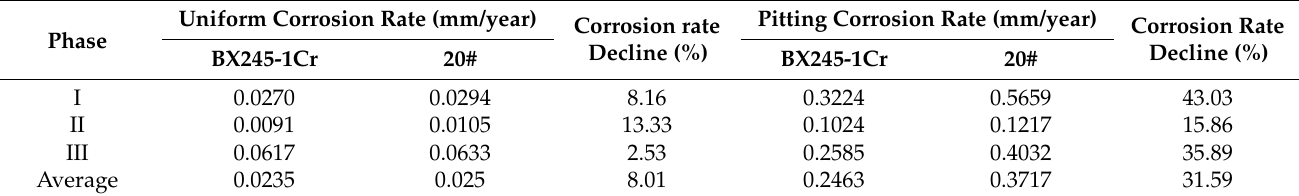
Table 18. Corrosion rate monitoring